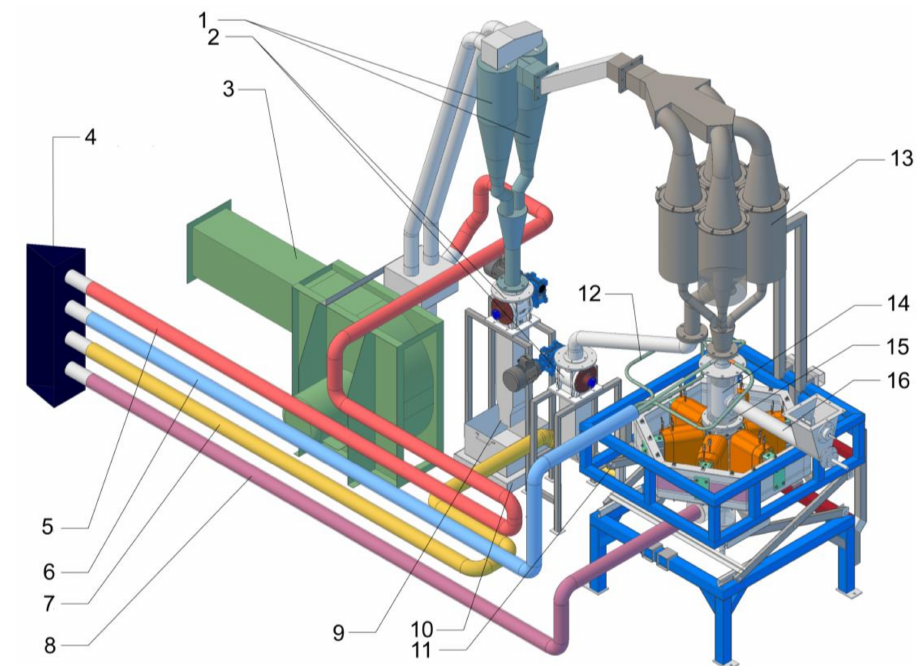
Figure 4. 3D model of the dry grinding and classification circuit with D200 EMM by ELTRAF. Material is fed to the installation by the screw feeder (no. 16) into the preliminary classifier (no. 14) situated above the mill from where larger grains drop down into the working chamber (no. 15) surrounded by 6 electromagnets which generate rotating magnetic field. Material is transported by the pneumatic transporting system. The air stream is taken form intake (no. 4) and exhausted trough the outlet (no. 3) directly connected to the main fan. The main air stream (no. 8) supplies the